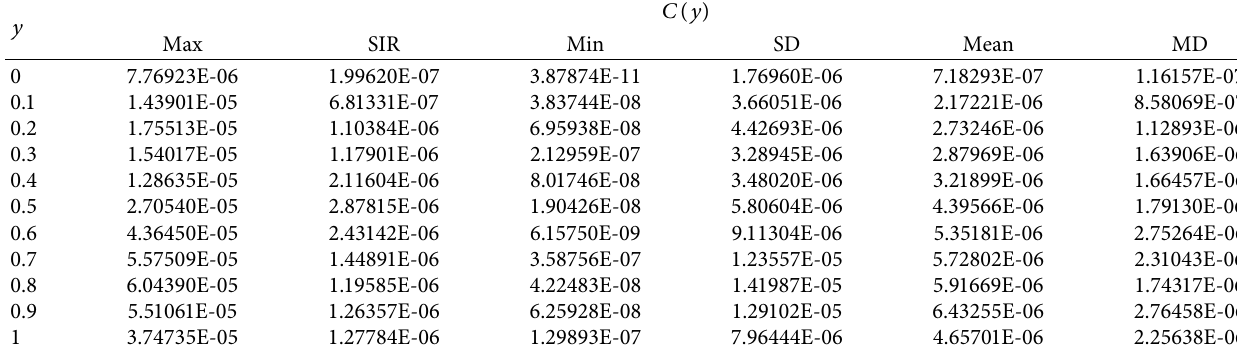
Table 8: Statistical performances for the class C ( y ) to solve the mathematical SEIR-NDC system.